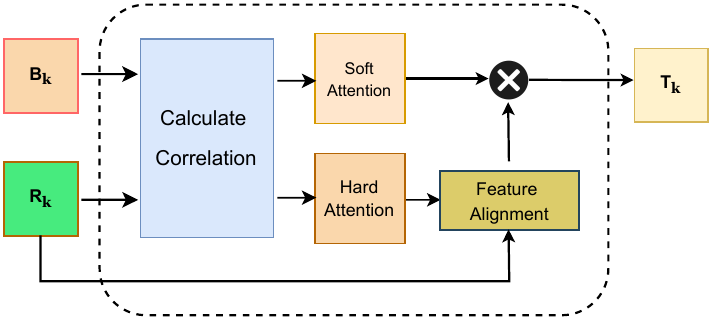
Figure 3. The process of feature fusion.